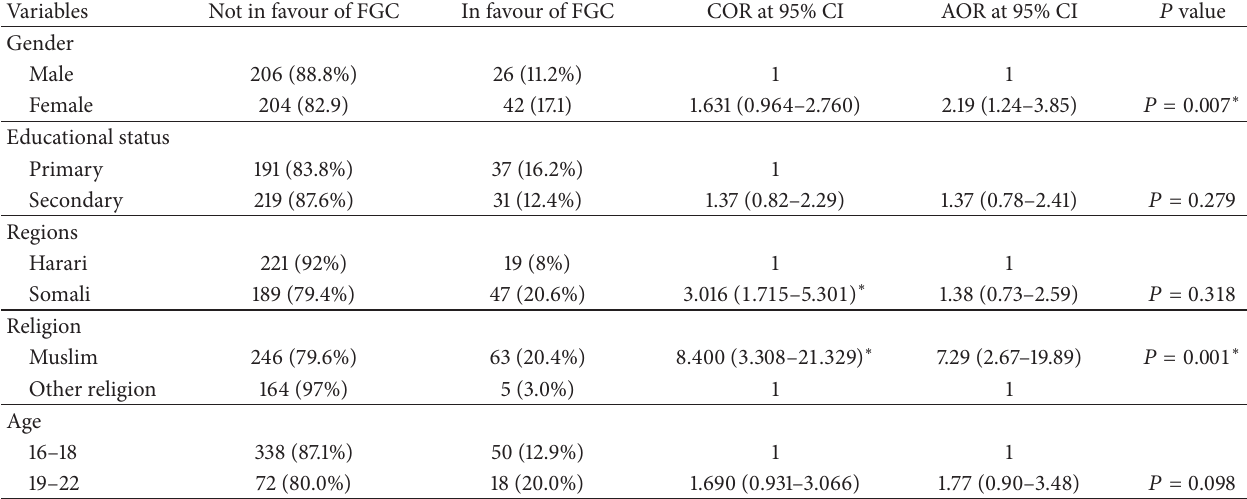
Table 5: A logistic regression analysis for the association of the attitude favoring/not favoring FGC with different categorical variables in Somali and Harari regions, Eastern